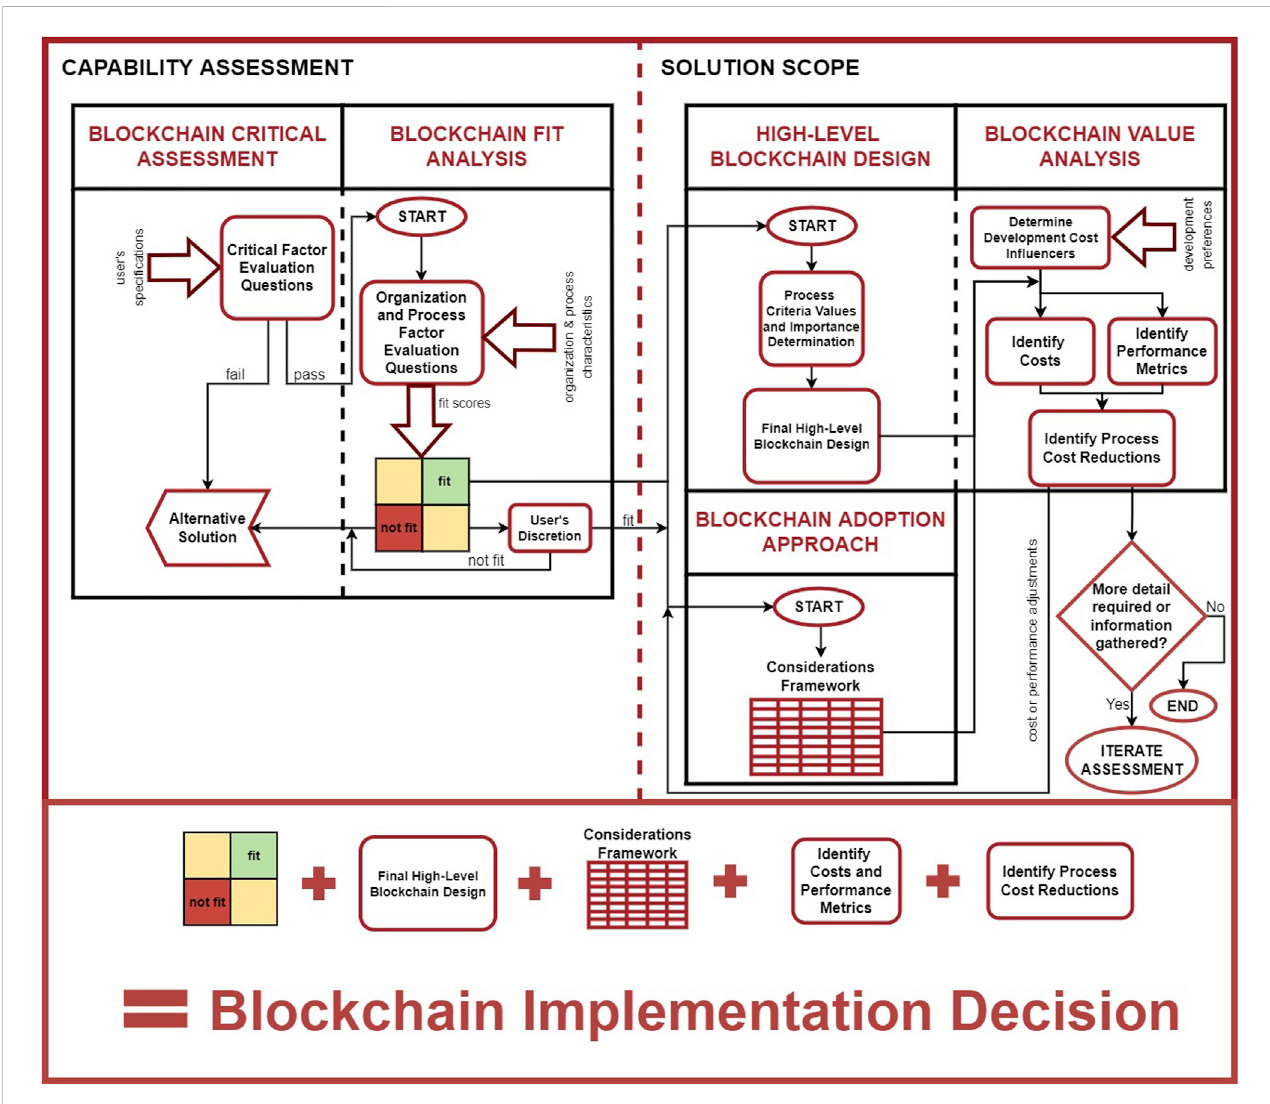
FIGURE 1 Blockchain Assessment